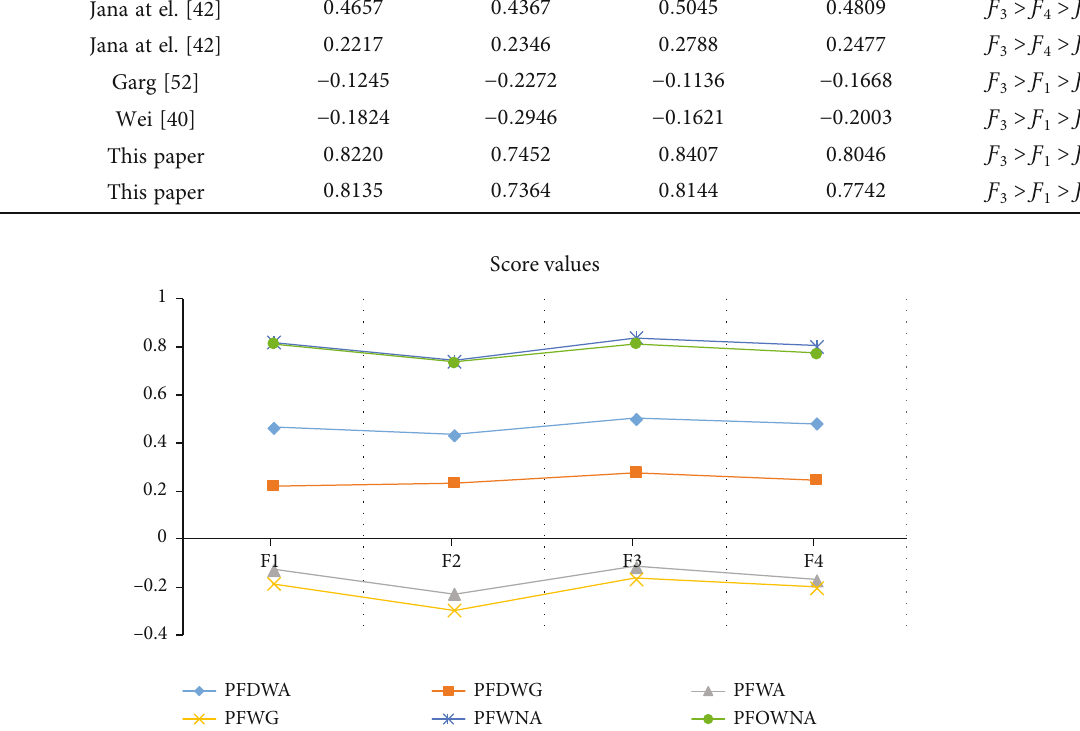
Figure 4: Pictorial analysis of validity and